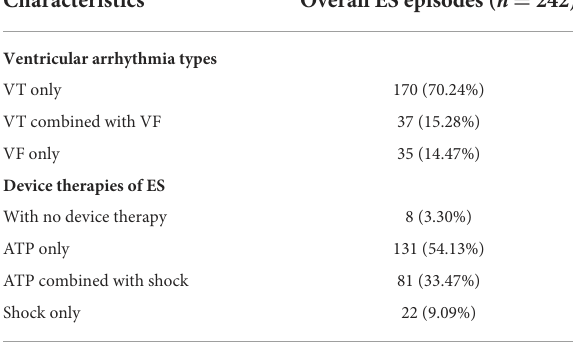
TABLE 2 Ventricular arrhythmias and device therapies of ES episodes during follow up.